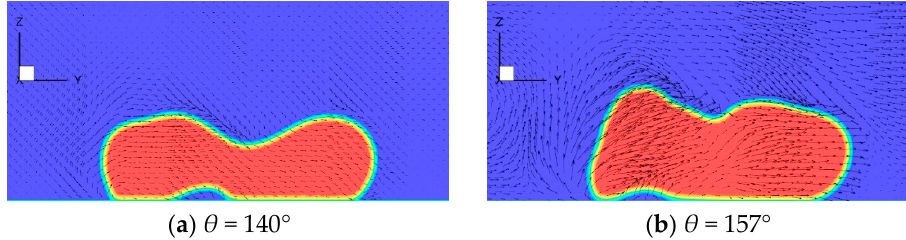
Figure 11. The different velocity field of droplet between θ = 140° and θ = 157° at v r = 1.5. Figure 11. The di ff erent velocity field of droplet between θ = 140 ◦ and θ = 157 ◦ at v r =